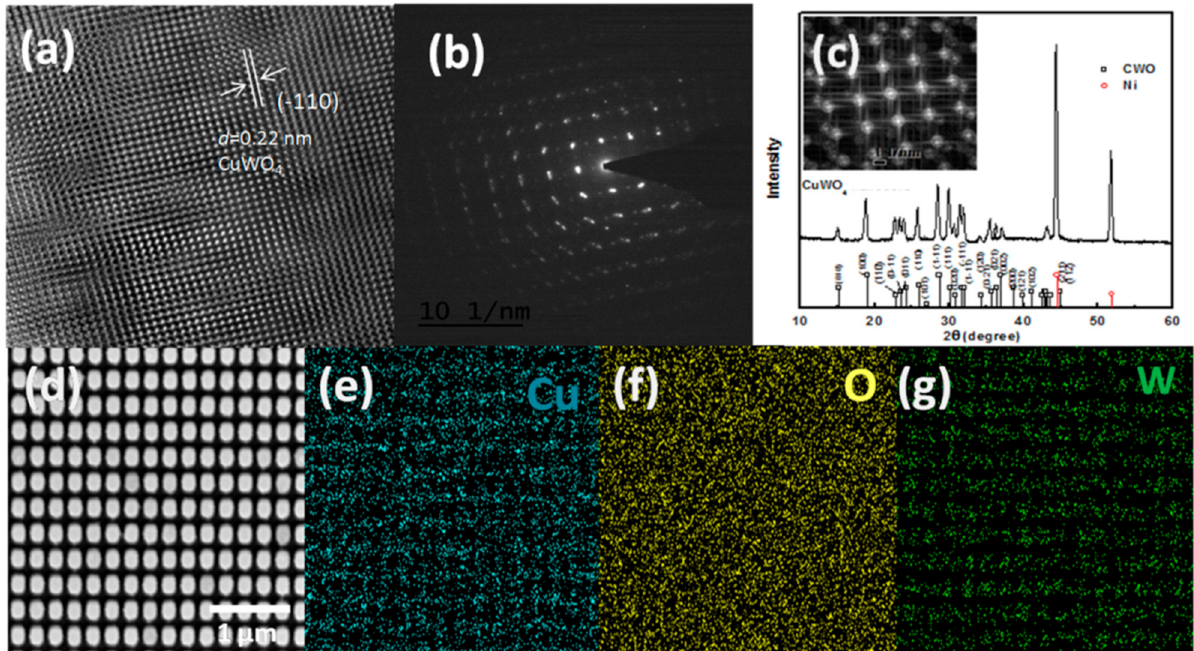
Figure 3. ( a ) High-resolution transmission electron microscopy (HRTEM) image of a sample of the photoanode of the CuWO 4 nanorod arrays after deposition; ( b ) a selected area from the electron diffraction pattern of a sample of the photoanode of the CuWO 4 nanorod arrays; ( c ) XRD pattern of a sample of the photoanode of the CuWO 4 nanorod arrays (insert: SAED pattern of a sample of the photoanode of the CuWO 4 nanorod arrays, the smaller image shows the inverse FFT cell); and ( d ) SEM images of the EDX mapping that represent ( e ) the Cu element, ( f ) the O element, and ( g ) the W element,